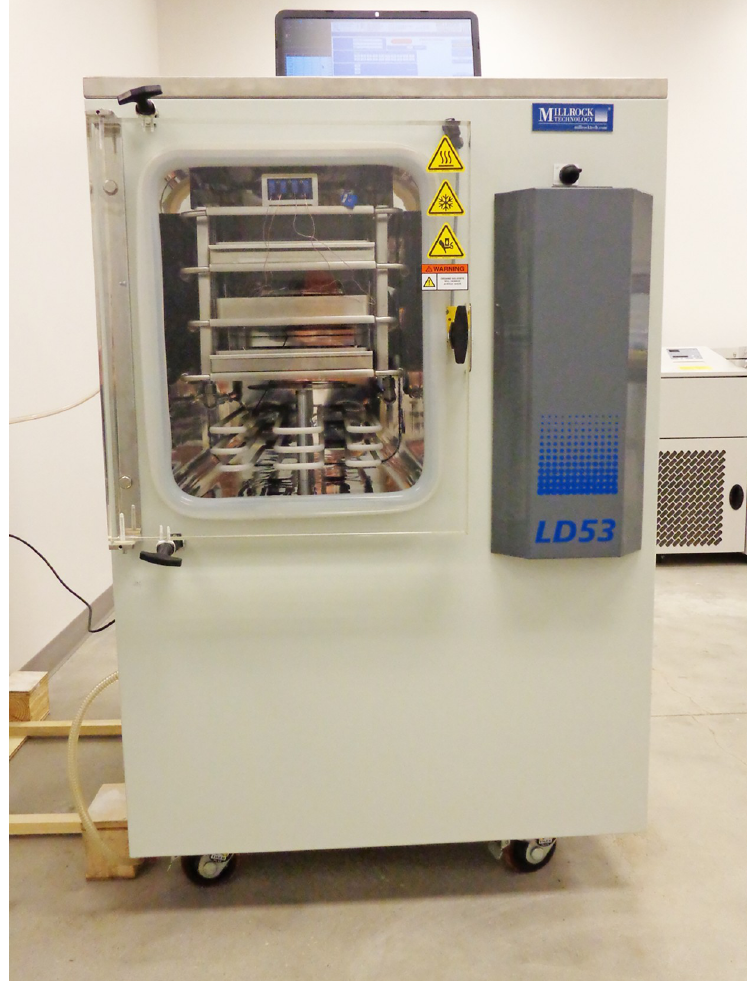
Fig 6. Shelf-type Freeze Dryer for lyophilizing HuBChE. Millrock Technology, model LD53S3, Kingston,